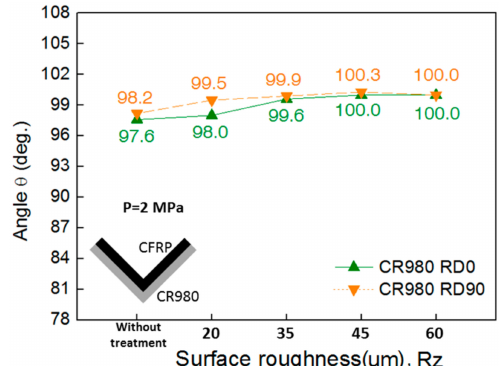
Figure 13. Angle of spring-back of CFRP/CR980 hybrid composites with different levels of surface roughness, conducted by a V-bending test under 2 MPa of the pressure.